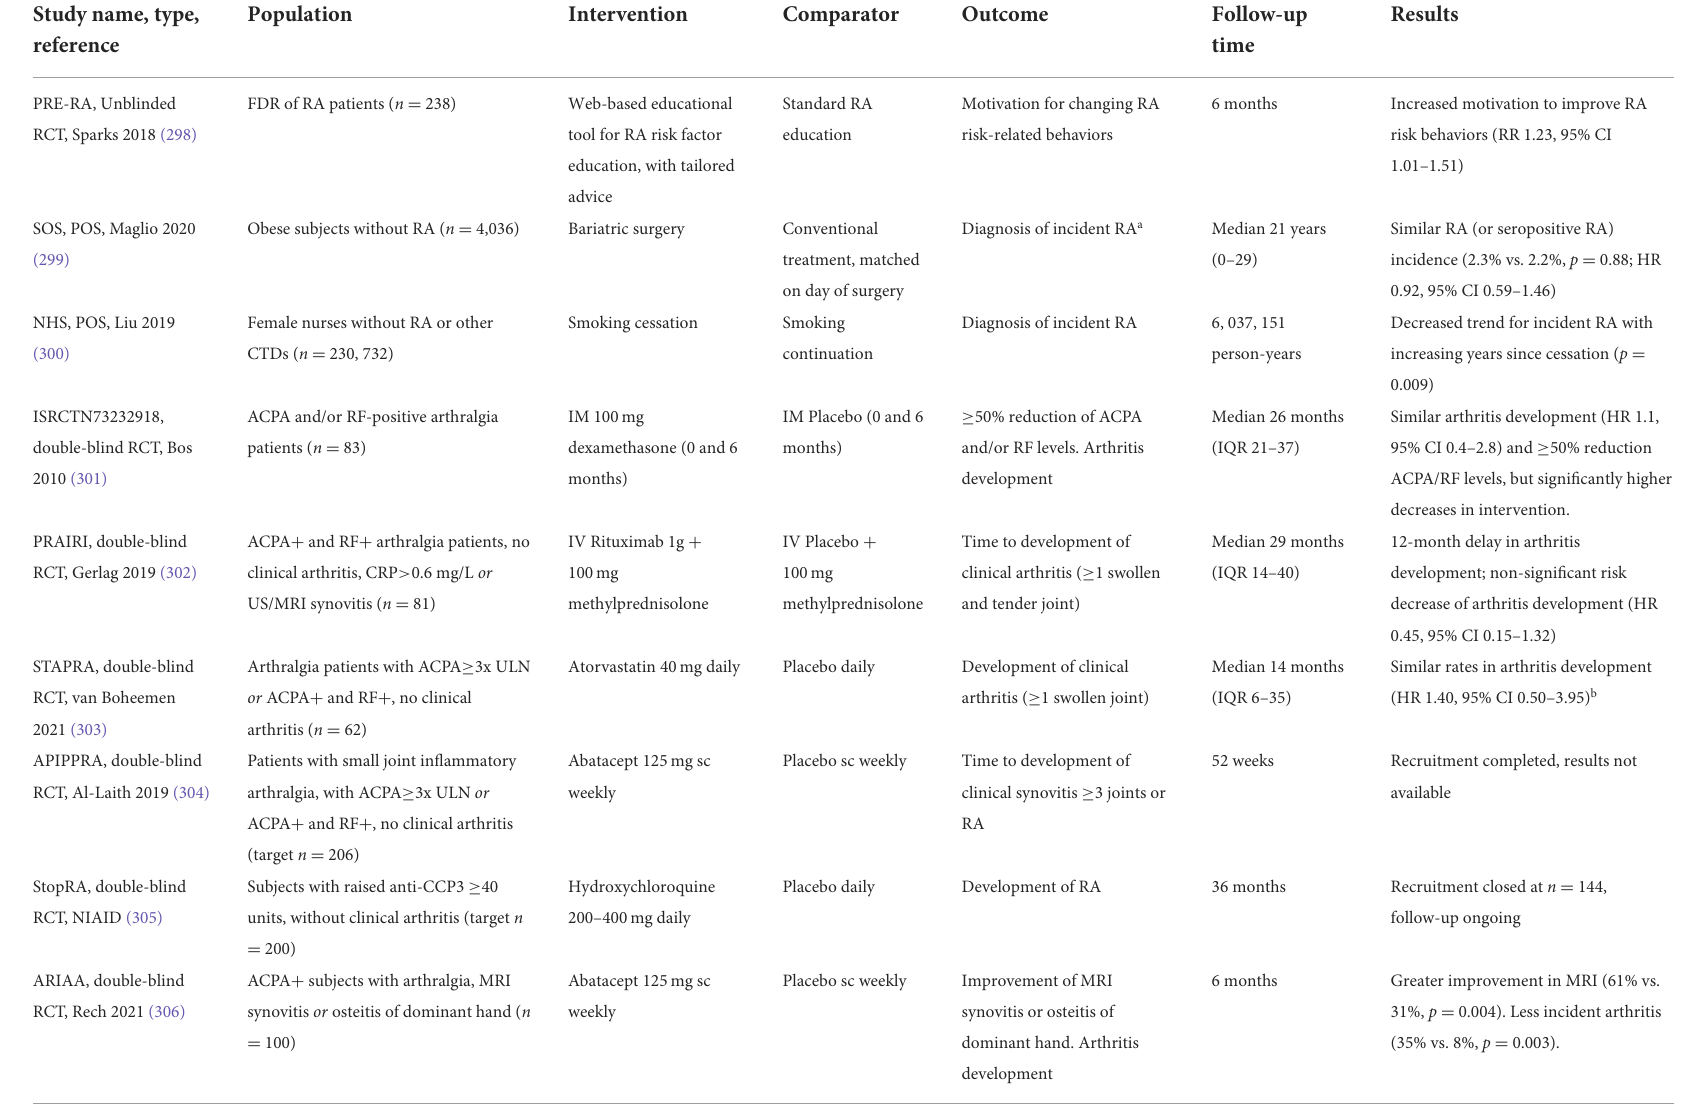
TABLE 3 Summary of studies investigating lifestyle and pharmacological interventions in preclinical